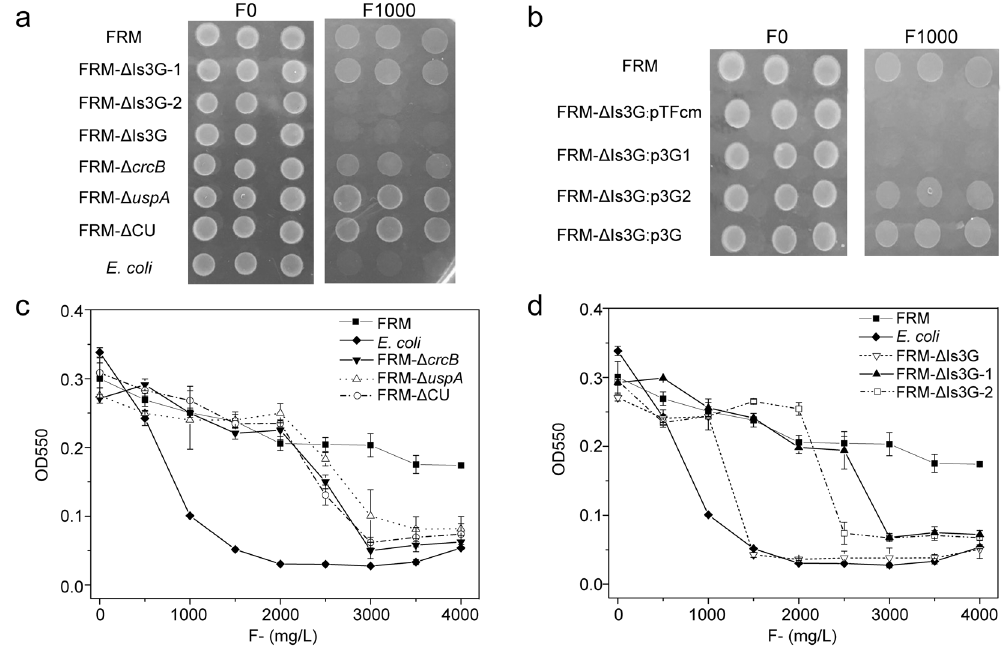
Figure 4. Examination of the fluoride resistance of E . cloacae FRM and knockout strains. ( a ) Eight strains were spotted onto Burk plates without fluoride (left) and with 1,000 mg/L fluoride (right). E . cloacae FRM- Δ